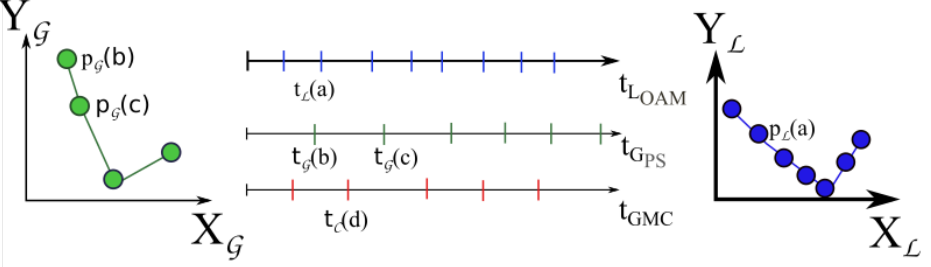
Figure 10. All three sensors sample at different rates. LOAM-trajectory and GNSS samples contain positions in different coordinate systems ( G and L